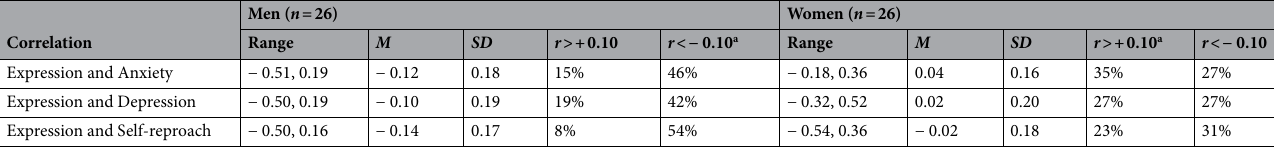
Table 2. Descriptive statistics for person-specific correlations between daily gender expression (feminine- to-masculine continuum) and three indices of psychological adjustment by gender. Data from 4 men and 1 woman are missing due to 0 (or near 0) variations in daily gender expression. Data in the r > + 0.10 and r < − 0.10 columns reflect the percentages of individuals of a given gender who had correlations between gender expression and psychological adjustment that exceeded thresholds for small effects (Cohen, 1988). a Indicates the hypothesized direction of correlation (i.e., sex-incongruent daily expression associated with